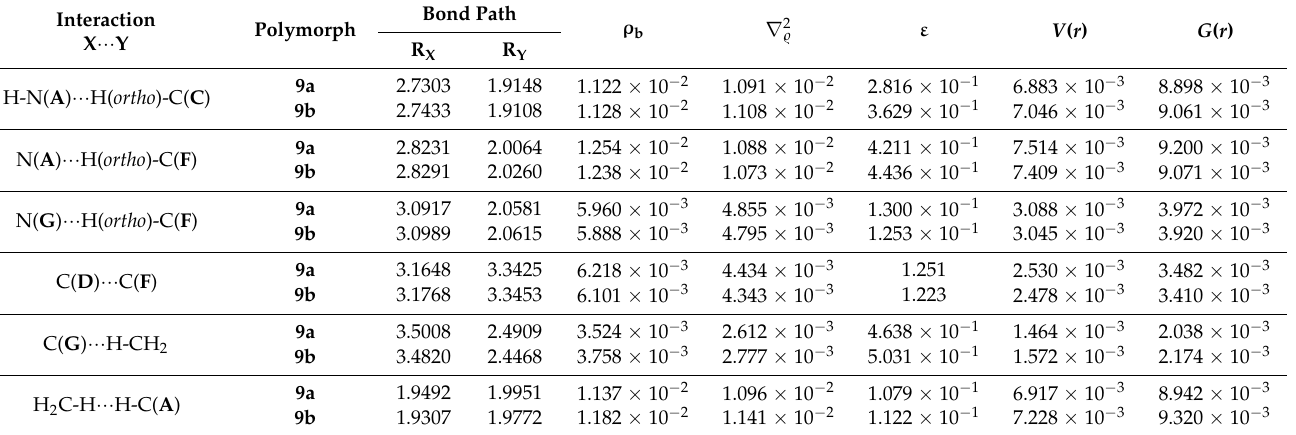
Table 3. Topological parameters 1 (in au) for closed-shell intramolecular BCPs in crystalline molecular units 9a and 9b . Ring sorting is presented in parentheses and using bold capital letters as described in Figure